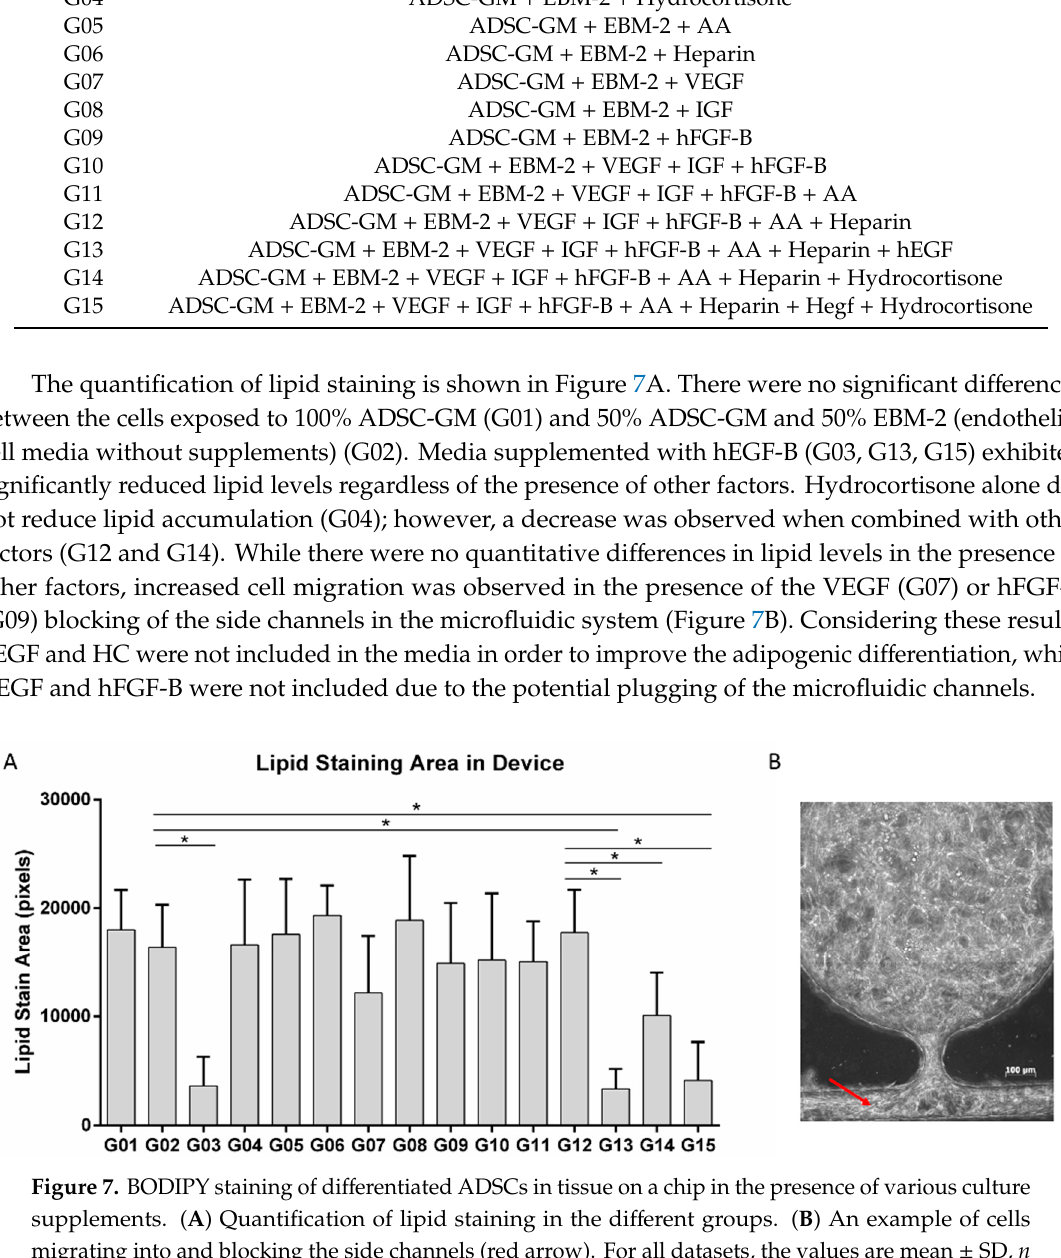
Table 3. Media groups for the screening of pro-adipogenic